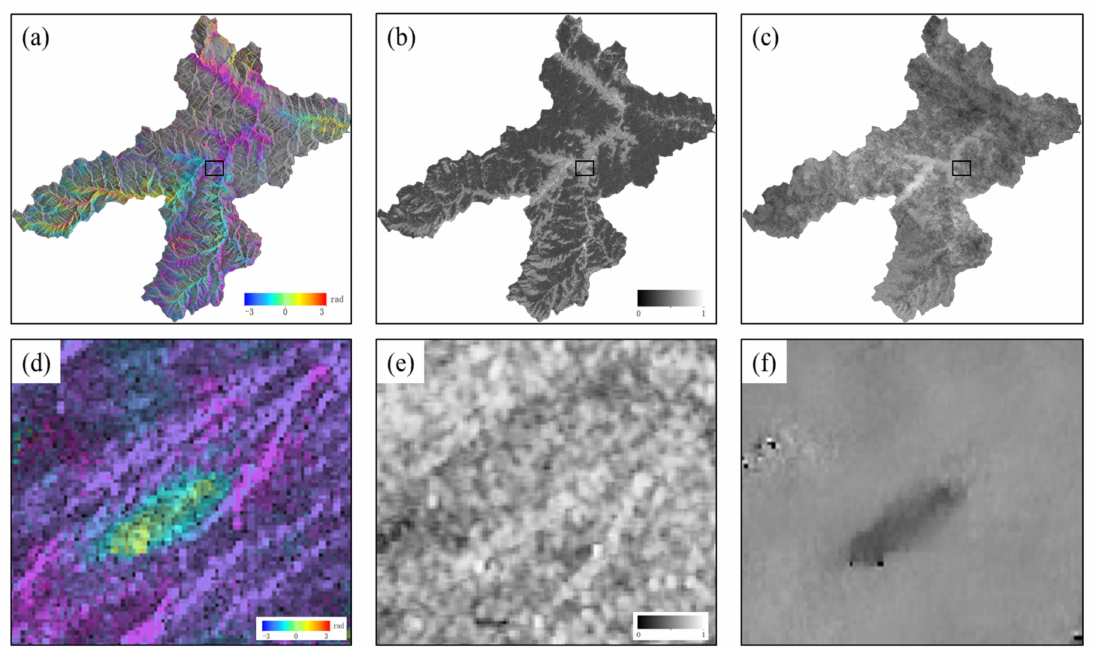
Figure 4. Interferogram and partial amplified diagram of 20170425-20170507 ascending orbit data. ( a ) is the overall interferogram of Maoxian county, ( b ) is the coherence coefficient diagram of Maoxian county, ( c ) is the unwrapping results of Maoxian County, ( d ) is the partial amplified interfero- gram, ( e ) is the partial amplified coherence coefficient diagram, and ( f ) is the partial amplified unwrapping results.